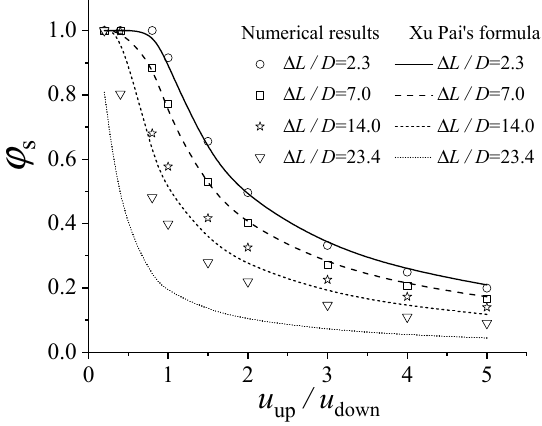
Figure 9. Impacts of u up / u down on series-flow ratio φ s .